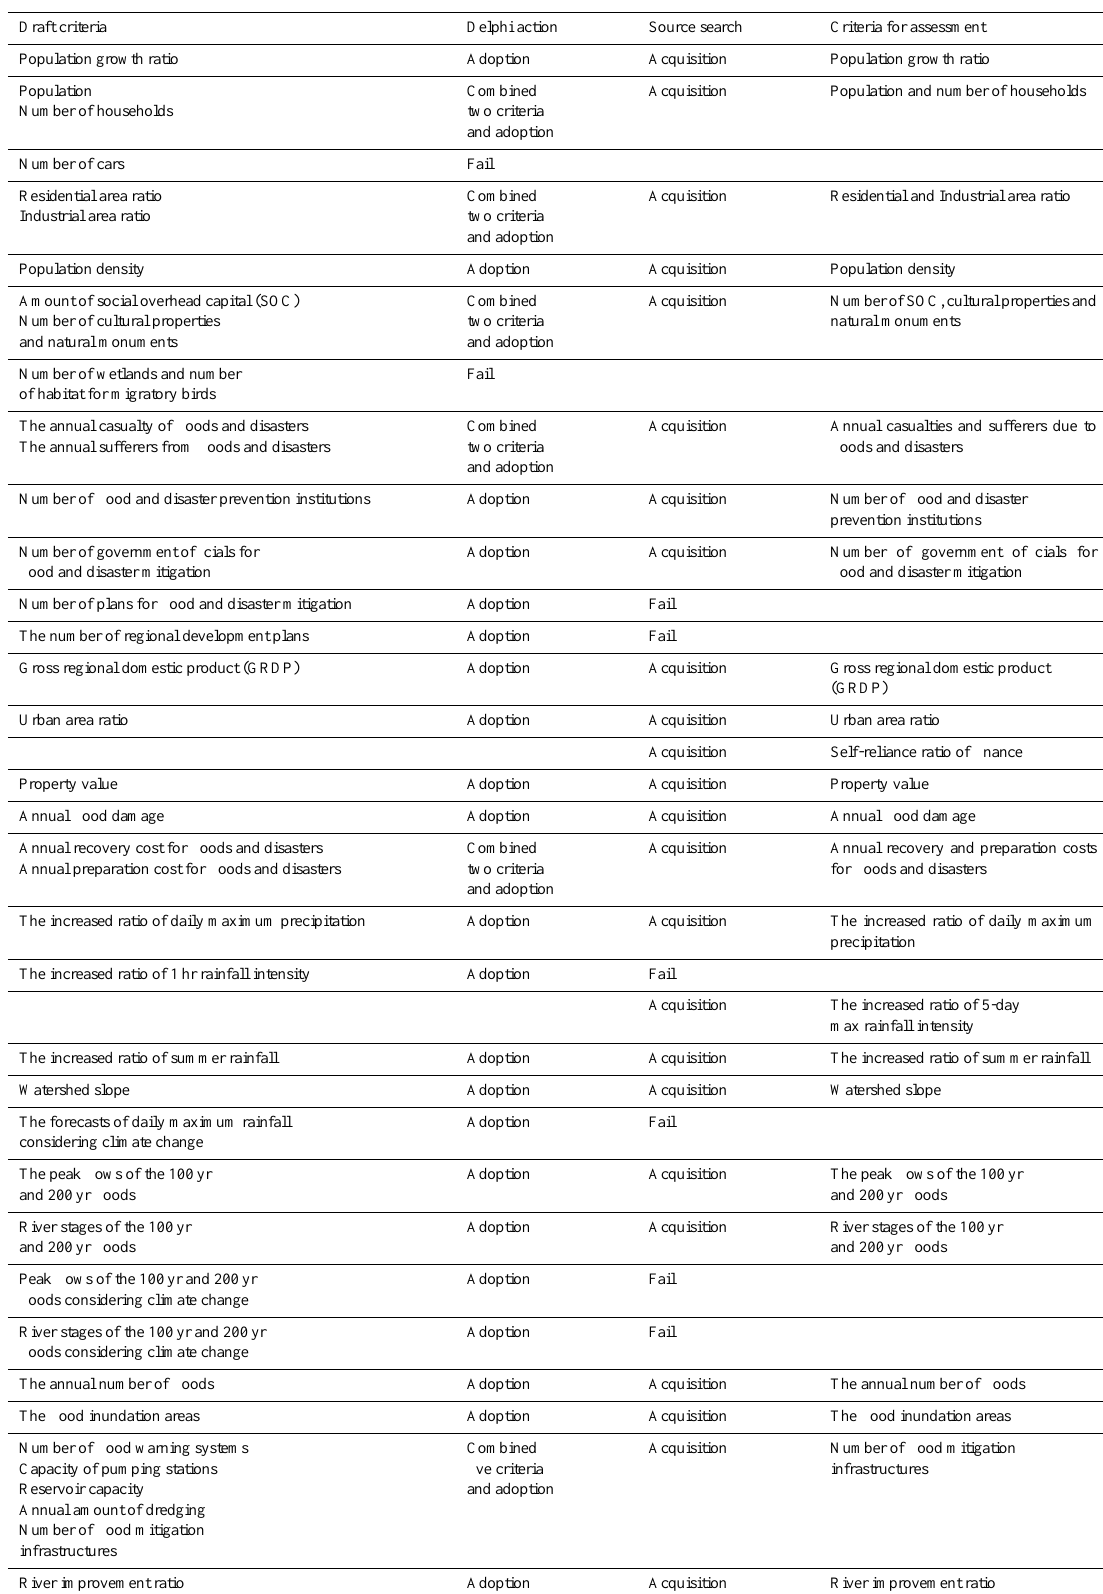
Table 3. Determination of assessment